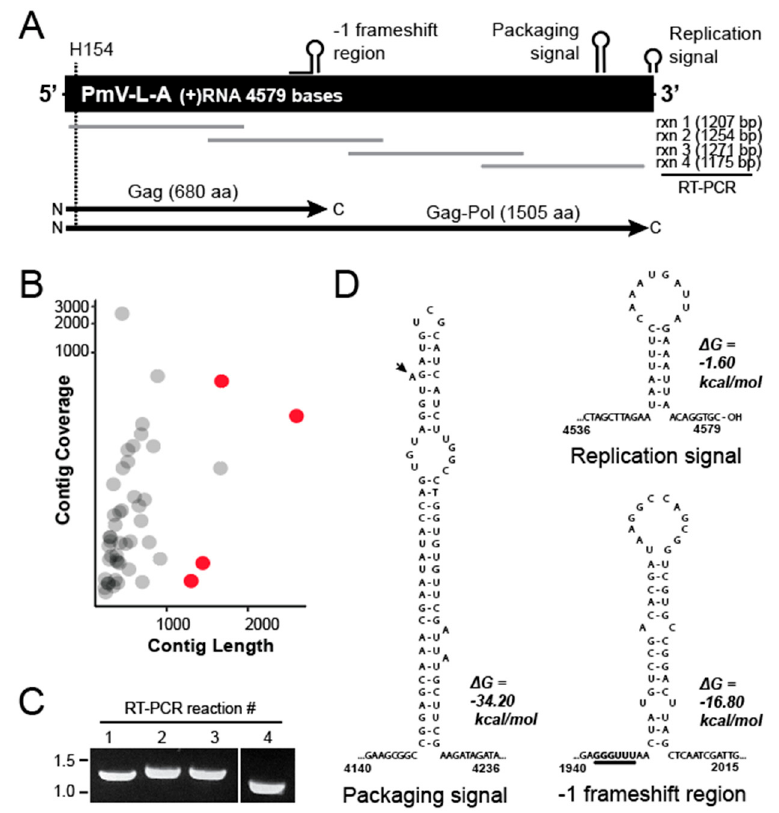
Figure 2. A dsRNA virus within P. membranifaciens has the genomic organization of a totivirus. ( A ) Schematic overview of the organization of the PmV-L-A genome, including the position of an RNA secondary structure, ORFs, and a conserved amino acid (H154) required for the cap-snatching activity of Gag. Rxn 1-4 show the position of RT-PCR products used to confirm the genome sequence of PmV-L-A by Sanger sequencing. ( B ) Sequence contigs after de novo assembly are represented by contig coverage and length. Blastx analysis enabled the identification of four contigs related to yeast totiviruses (red). ( C ) Products of RT-PCR, using overlapping primer pairs to confirm the assembled sequence of PmV-L-A. ( D ) RNA secondary structure predictions were performed using the mFold server [40].